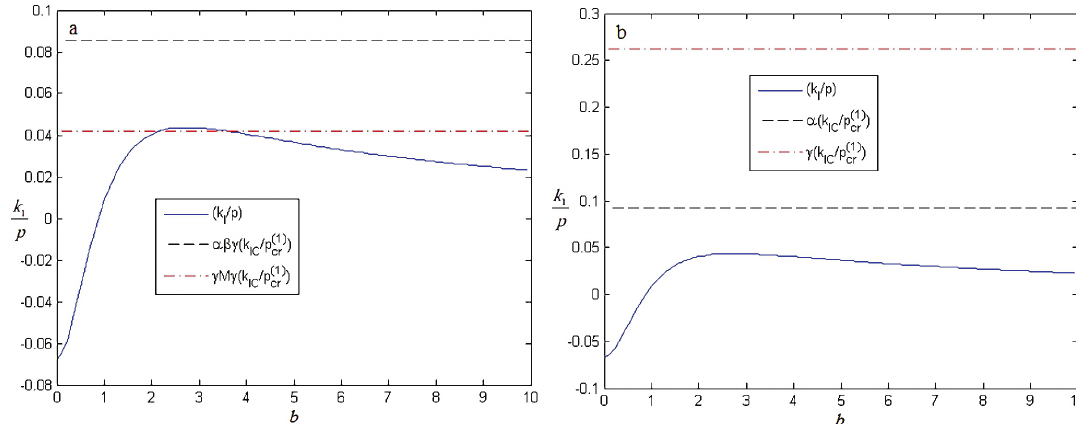
Figure 10. Normalized mode I stress intensity factors and normalized critical stress intensity factor for (a-b)/d=1, η=0.8, d=1: (a) composite αβγ and composite γMγ ; (b) original ferrite α and original austenite